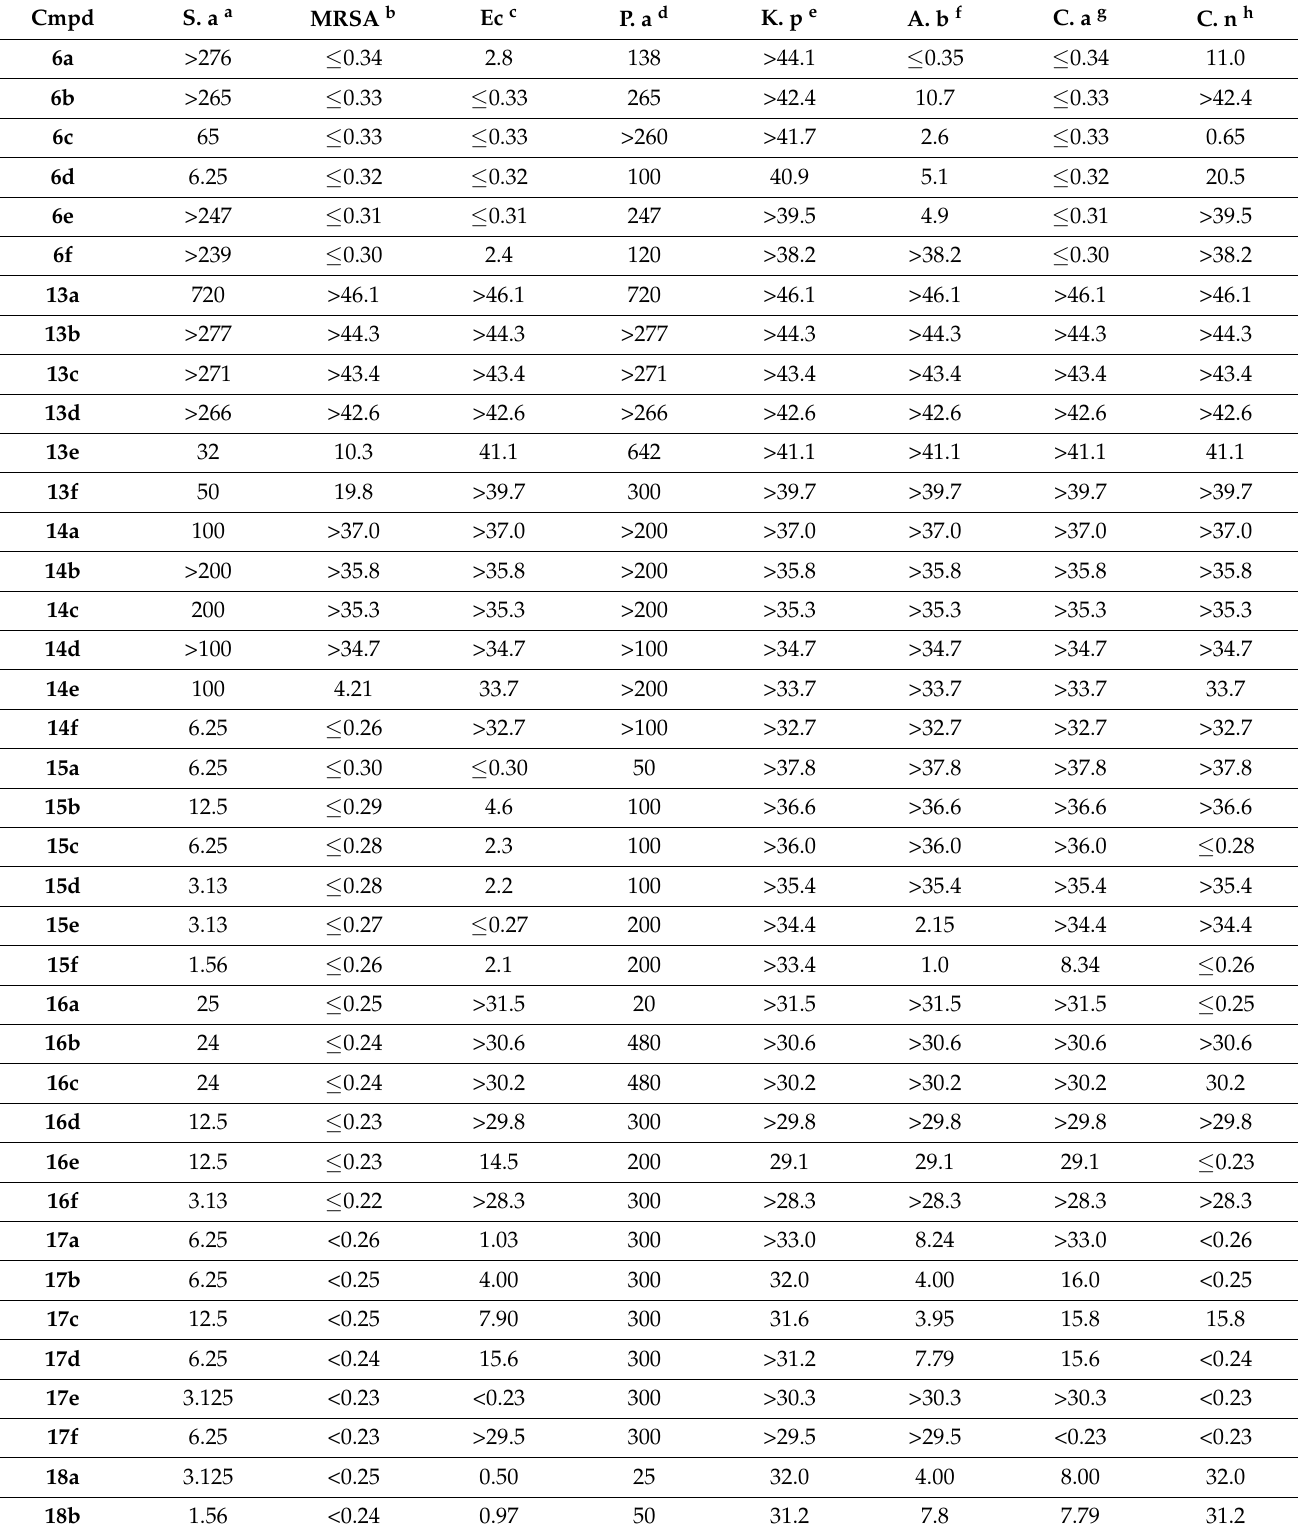
Table 1. Antimicrobial and antifungal activities (MIC, µ M) of analogues 6, 13 – 18